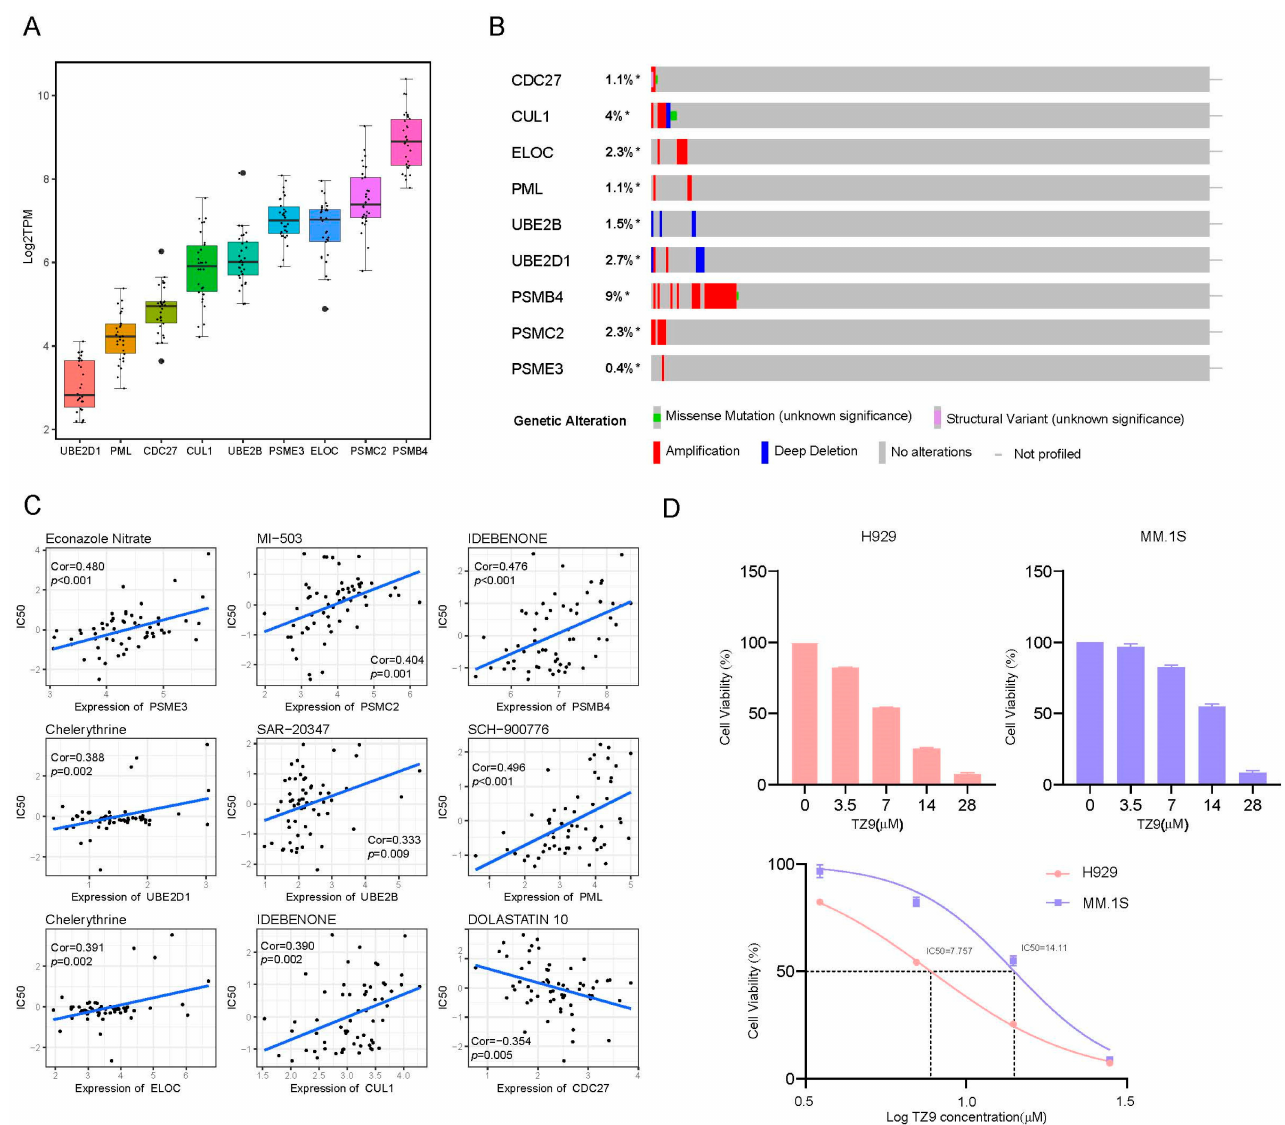
Figure 8. External validation in online databases. ( A ) The expression of UPPGs in HMCLs demon- strated in CCLE. ( B ) The mutation profile of MM samples from cBioPortal. ( C ) Correlation analysis between nine UPPGs and their potential targeted drugs. ( D ) TZ9 treated H929, MM.1S cell lines. HMCLs—-Human myeloma cell lines. * p <